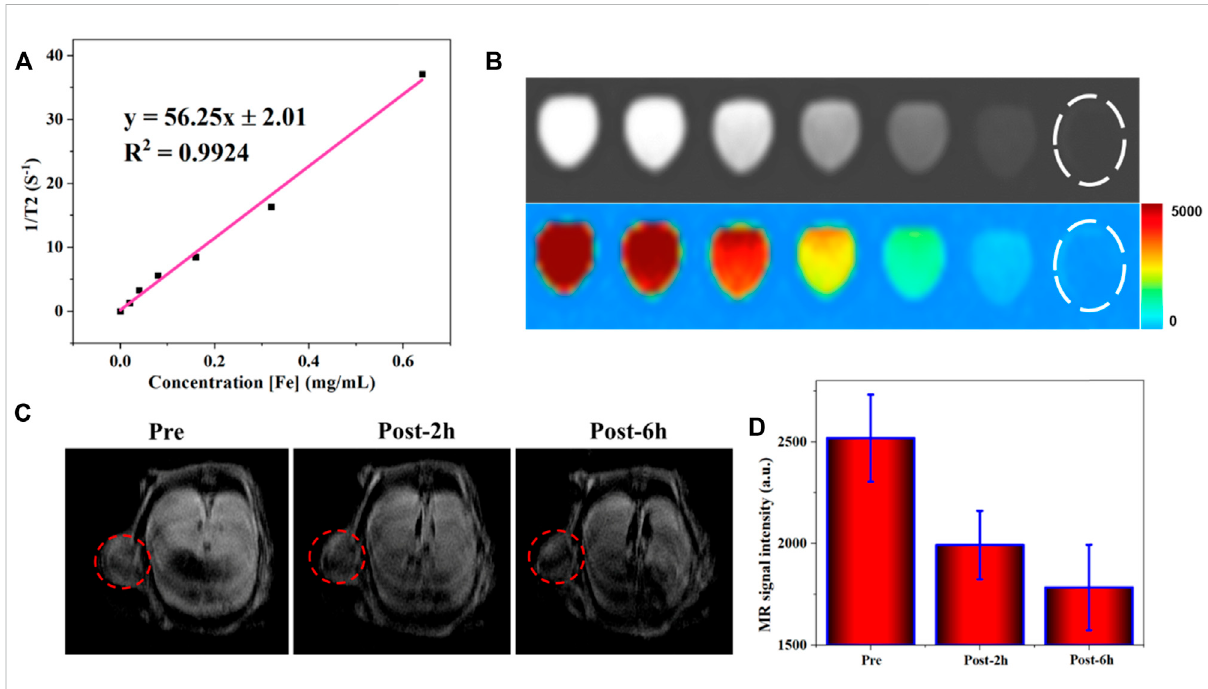
FIGURE 4 MR contrast enhancing ability of FVNH. (A) The transverse relaxation rate (1/T2, s-1) as a function of Fe concentration (mM) for FVNH at clinal 3.0 T MRI scanner. (B) T2W MR and pseudo-color images at Fe concentrations. (C) In vivo MR (T2W) images in cancer before and after injection of FVNH NPs. (D) MRI signal intensity changes in the tumor